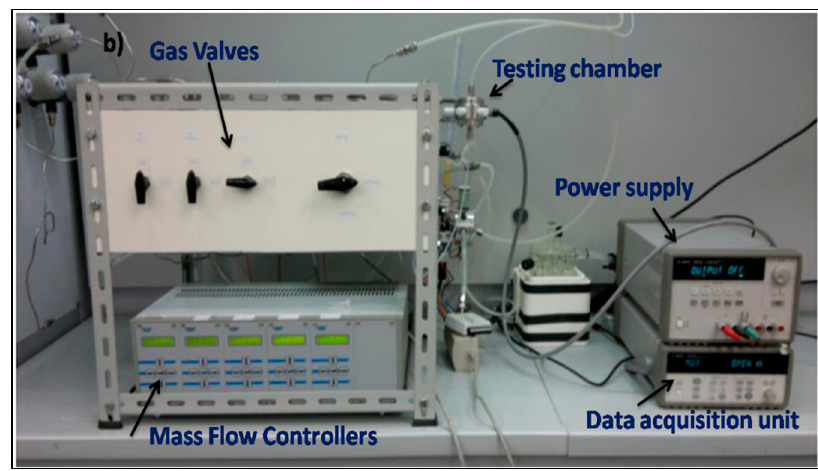
Figure 1. Photo of ( a ) the sensing device and ( b ) the measurement system.